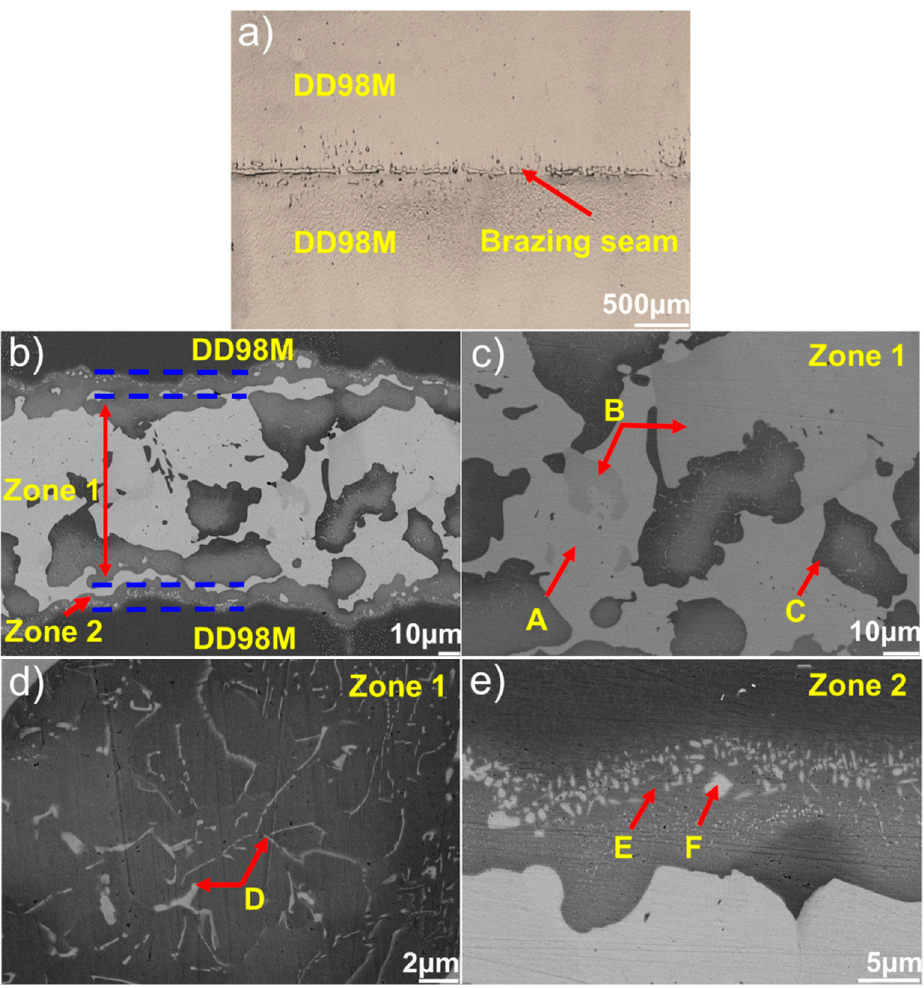
Figure 2. Macro- and micro- structure of the DD98M/Pd-Si/DD98M joint brazed at 1060 ° C for 30 min: ( a ) macro image, ( b ) general morphology, ( c ) magnified zone 1, ( d ) magnified phase C, and ( e ) magnified zone 2. Table 3. Chemical composition of the phases in the DD98M-DD98M brazed joint (at.%).